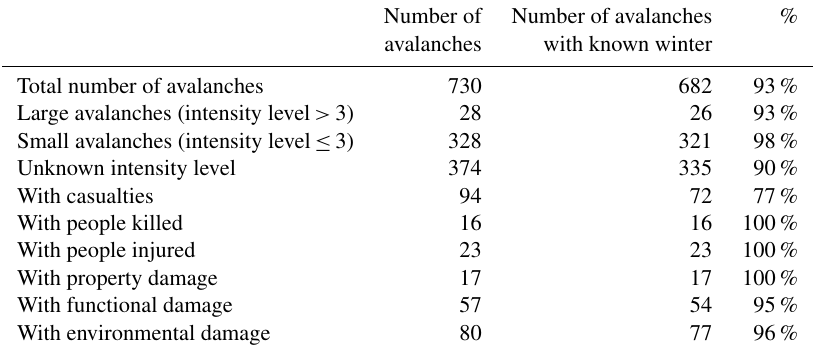
Table 3. Typology of avalanches. Intensity level refers to a specific scale adapted to the characteristics of avalanche activity in the Vosges Mountains. By casualties, we mean either with people killed, injured or simply caught by the flow without any harmful consequences. Property damage refers mostly to partial or total destruction of one or several buildings. In rare cases, it also corresponds to damage to bridges or fences. Functional damage refers to traffic perturbation on roads. Environmental damage refers to the disruption of ecosystems, including the destruction of large forest stands.